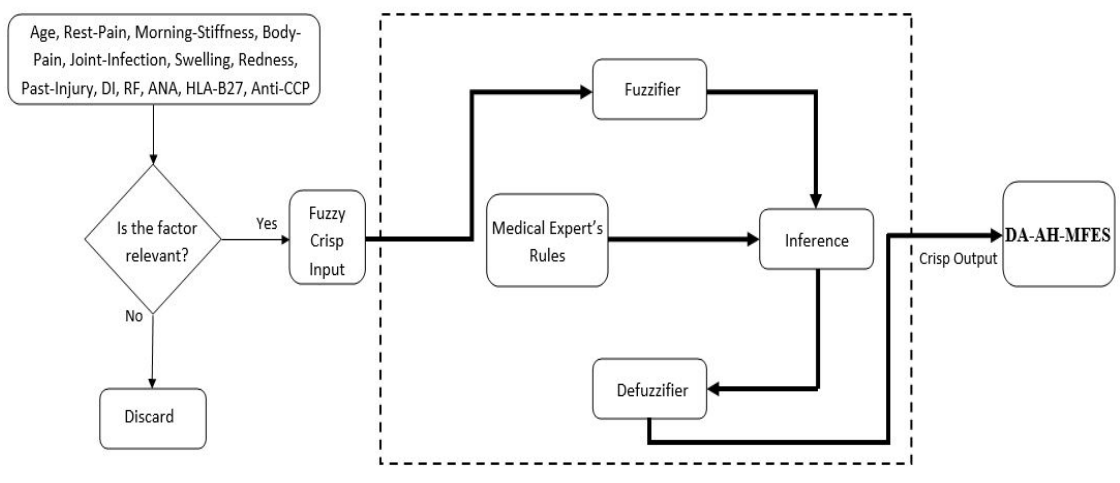
Figure 1. Proposed DA-AH-MFES based Expert System Methodology